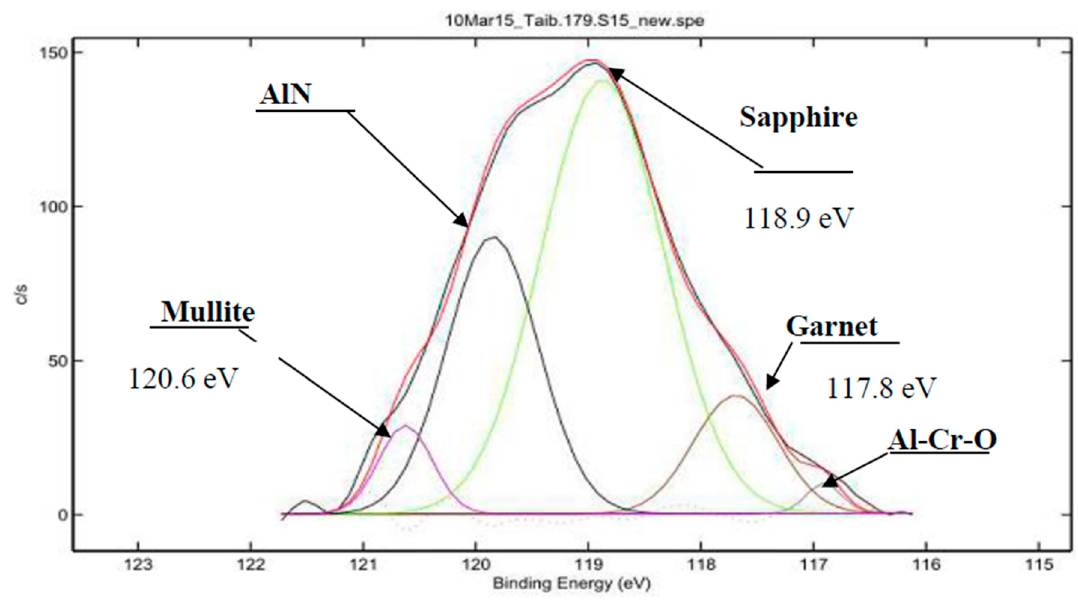
Figure 2. HR XPS spectra of complex tribo-oxides forming the beginning of the running-in stage (15 m length of cut): Al 2s spectrum [49] .